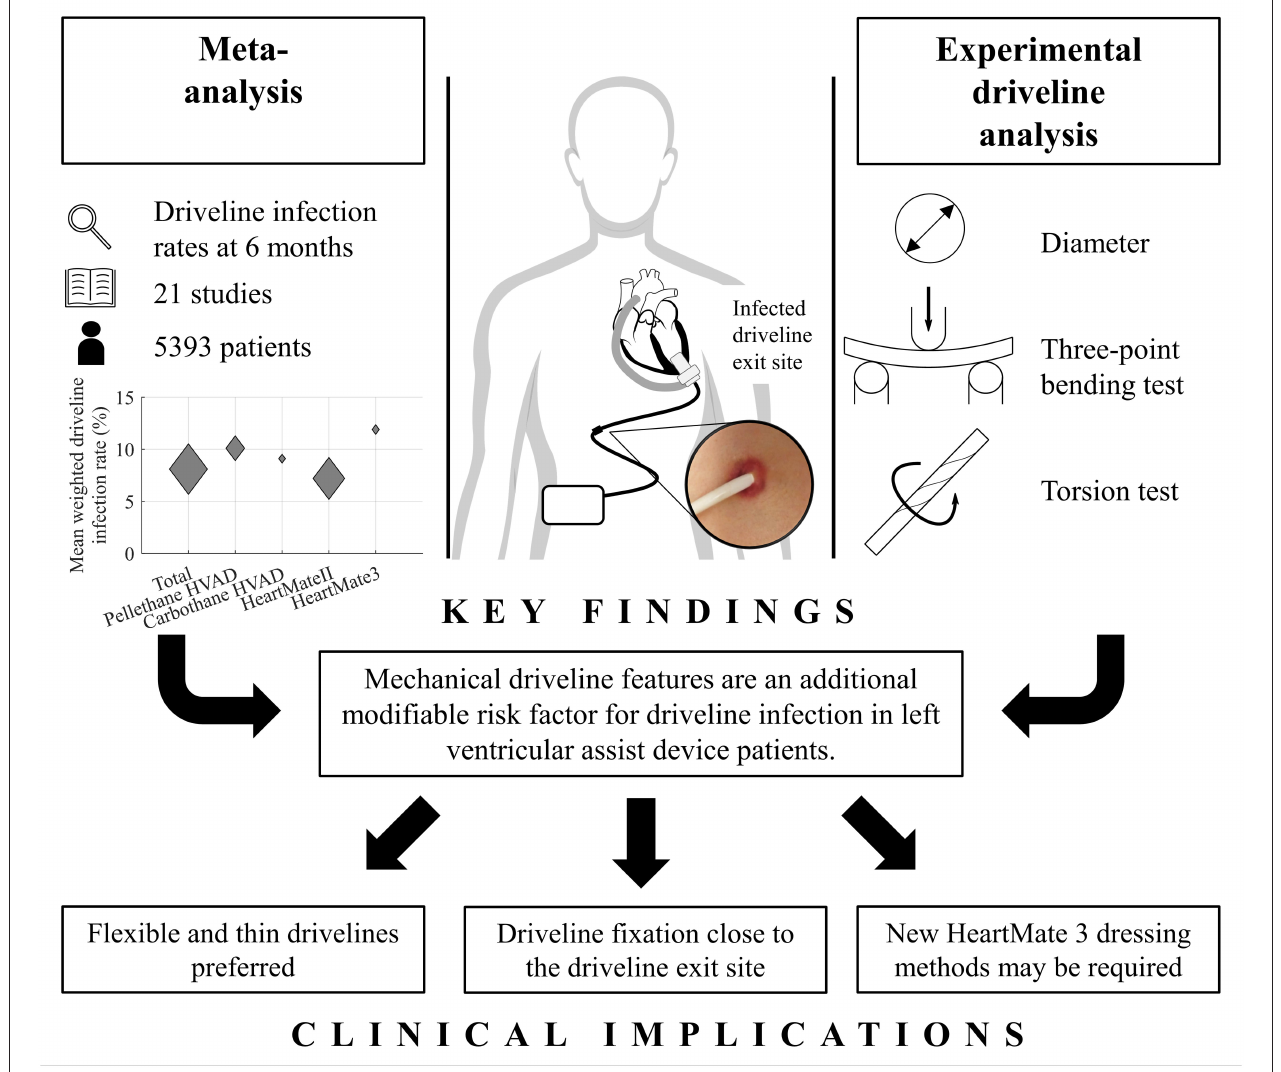
FIGURE 6 | Graphical abstract summarizing the in-vivo and ex-vivo analysis of mechanical driveline features as a risk factor for driveline